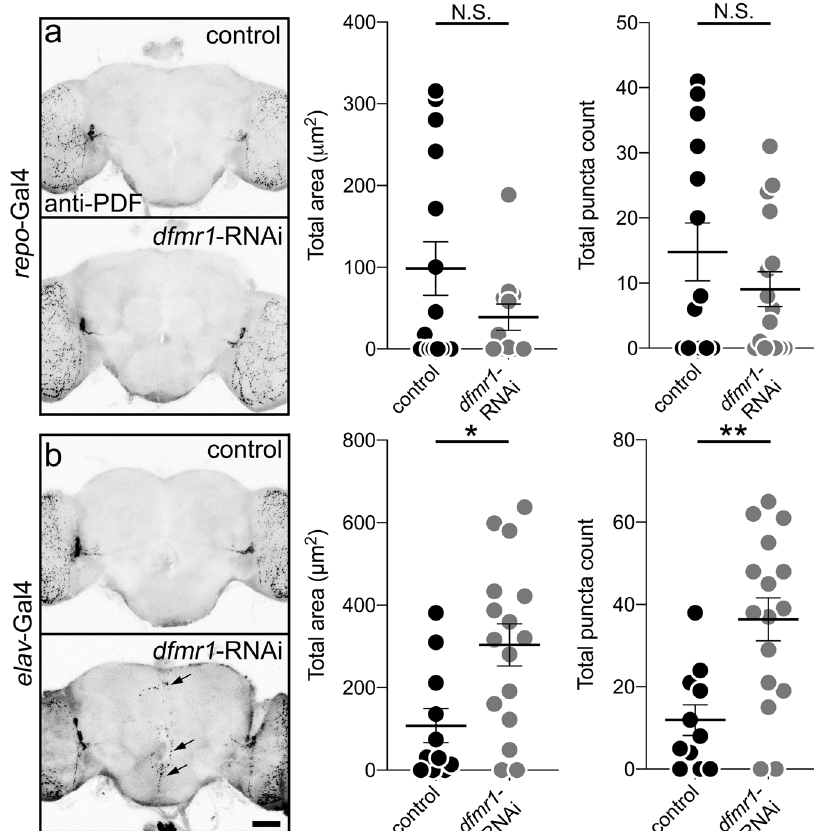
Fig. 7 FMRP is required speci fi cally within neurons for PDF-Tri neuron elimination. a Whole brains (5 DPE) labeled with anti-PDF in transgenic glial driver control ( repo -Gal4/ + , top) and expressing dfmr1 -RNAi targeted to glia ( repo -Gal4 > dfmr1 -RNAi 35200 , bottom). Both genotypes exhibit a lack of PDF- Tri neurons in the central brain. Right: Graphs showing central PDF-Tri area (left) and PDF + puncta (right) in the two genotypes. Area: two-sided Mann – Whitney, p = 0.5700, 98.62 ± 32.84 n = 15 control, 38.84 ± 16.17 n = 12 dfmr1 -RNAi; puncta: two-sided t test, p = 0.2650, 14.79 ± 4.432 n = 14 control, 9.063 ± 2.676 n = 16 dfmr1 -RNAi. b Brains (5 DPE) labeled with anti-PDF in the transgenic neuron driver control ( elav -Gal4/ + , top) and expressing dfmr1 -RNAi targeted to neurons ( elav -Gal4> dfmr1 -RNAi 35200 , bottom). The PDF-Tri neurons are absent in controls, but persist when FMRP function is removed in neurons (arrows). Right: Graphs showing anti-PDF area (left) and PDF + puncta (right) in the two genotypes. Area: two-sided t test, p = 0.0105, 108.1 ± 40.93 n = 11 control, 303.7 ± 51.3 n = 16 dfmr1 -RNAi; puncta: two-sided t test, p = 0.0018, 11.91 ± 3.706 n = 11 control, 36.38 ± 5.169 n = 16 dfmr1 -RNAi. Scatter plot graphs show mean ± SEM. Sample size is n = number of animals. Signi fi cance shown for p > 0.05 (not signi fi cant, N.S.), p < 0.05 (*), and p < 0.01 (**). Scale bar: 50 μ m. Source data for this fi gure are provided in Source Data fi